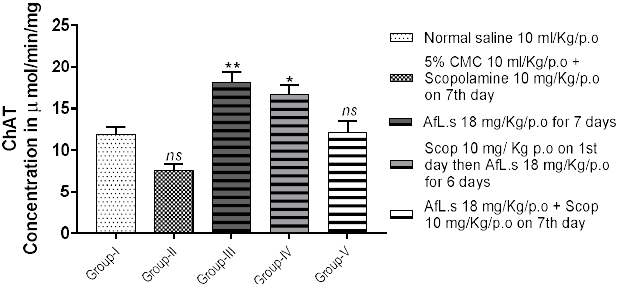
Figure 4. Effect of AfL.s on concentration of ChAT in mice brains. Data are presented as mean ± SEM ( n = 6) and one-way ANOVA (Dunnett’s test) was applied by comparing all groups with G-I. The signs ns , *, ** and *** presented the p values as ≥ 0.05, ≤ 0.05, ≤ 0.01, and ≤ 0.001 respectively.